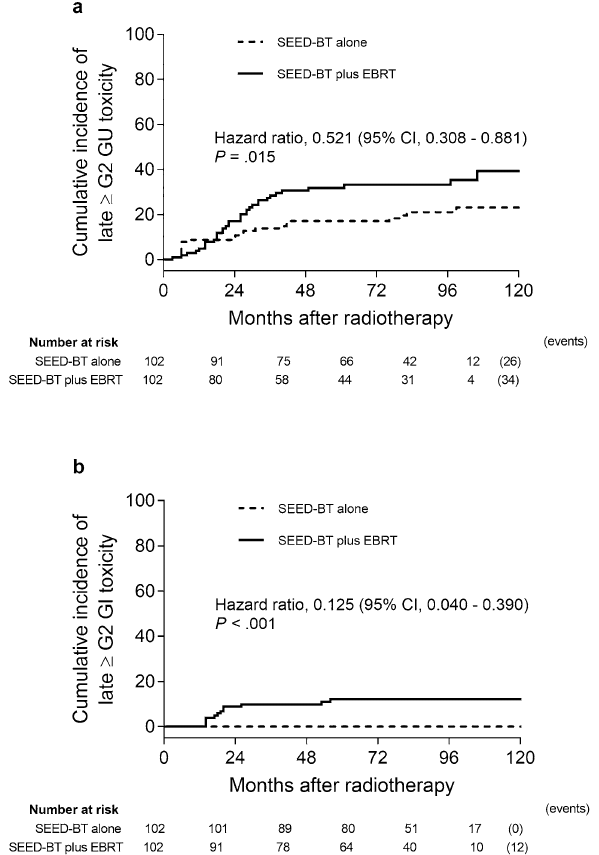
Figure 4. Kaplan–Meier estimates of grade 2 (G2) or greater late toxicities in patients treated with seed brachytherapy (SEED-BT) alone or with SEED-BT plus external-beam radiotherapy (EBRT),